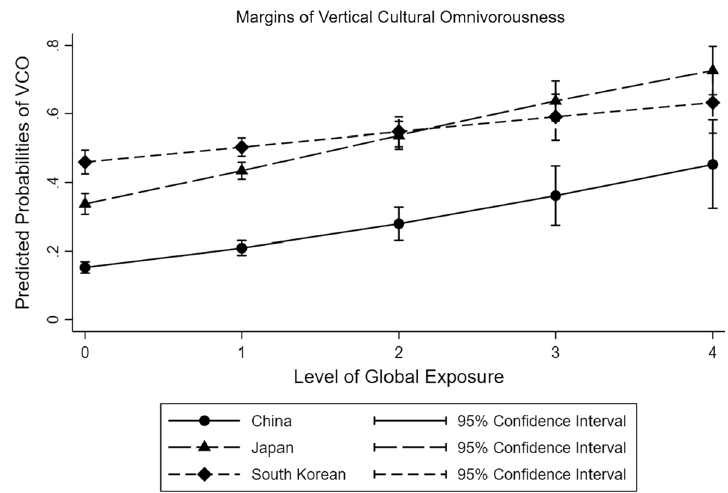
Fig. 2 Predicted correlation between global exposure and vertical cultural omnivorousness in China, Japan, and South